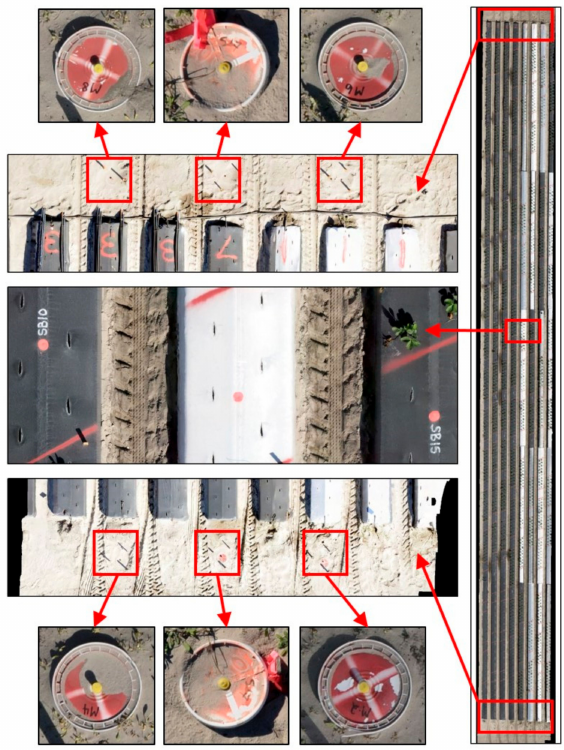
Figure 2. Targets at ends of beds and on beds for 3D modeling. Images were acquired using a custom-built platform towed by a tractor driven through the strawberry beds (Figure 3). Two consumer-grade Nikon D-300 digital cameras were used. The first camera captured Red-Green-Blue (RGB) imagery, and the other was a camera modified by removing the near-infrared (NIR) filter to capture NIR imagery. The cameras were mounted 3.5 m above ground and driven at 0.5 m per second to allow for about 70% forward overlap between images. Factoring in the distance between adjacent beds created 60% sidelap between the acquired images, which was needed to construct 3D models. The cameras were automatically triggered by a software program and hardware interface developed in-house that synchronized the RGB and NIR camera triggers and acquired a GNSS time stamp for each camera trigger instance [15,16]. Imaging trajectory was collected during the image acquisition mission using a geodetic-grade GNSS receiver mounted on the cameras’ carrying platform. The GNSS trajectory data were analyzed using kinematic post-processing analysis techniques. Camera trigger time stamps were matched with the GNSS trajectory to produce camera trigger locations. The images captured by the RGB and NIR cameras had about 0.5 mm spatial resolution in their raw form. Based on the time of day for image collection, which was the same across the season, the images were captured only while the tractor was moving in the south to north direction to avoid shadows from the platform and to keep shadows in the canopy